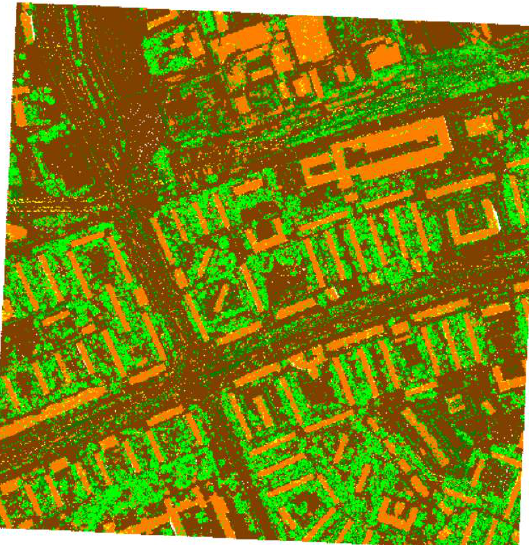
Figure 4. Automatic classification in Global